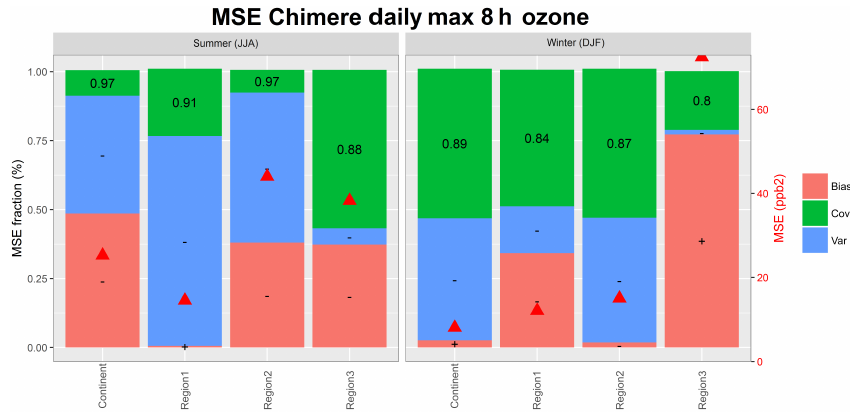
Figure 15. As in Fig. 11 for the rolling average daily maximum 8h ozone time